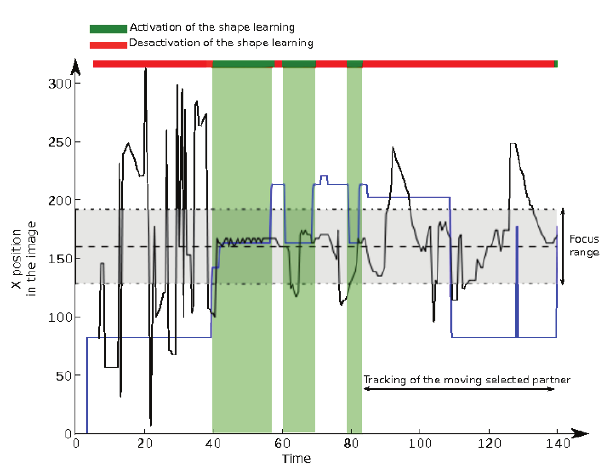
Figure 12. Partner detection and tracking: Experimental results in real condi- tions by combining synchrony based and shape based strategies